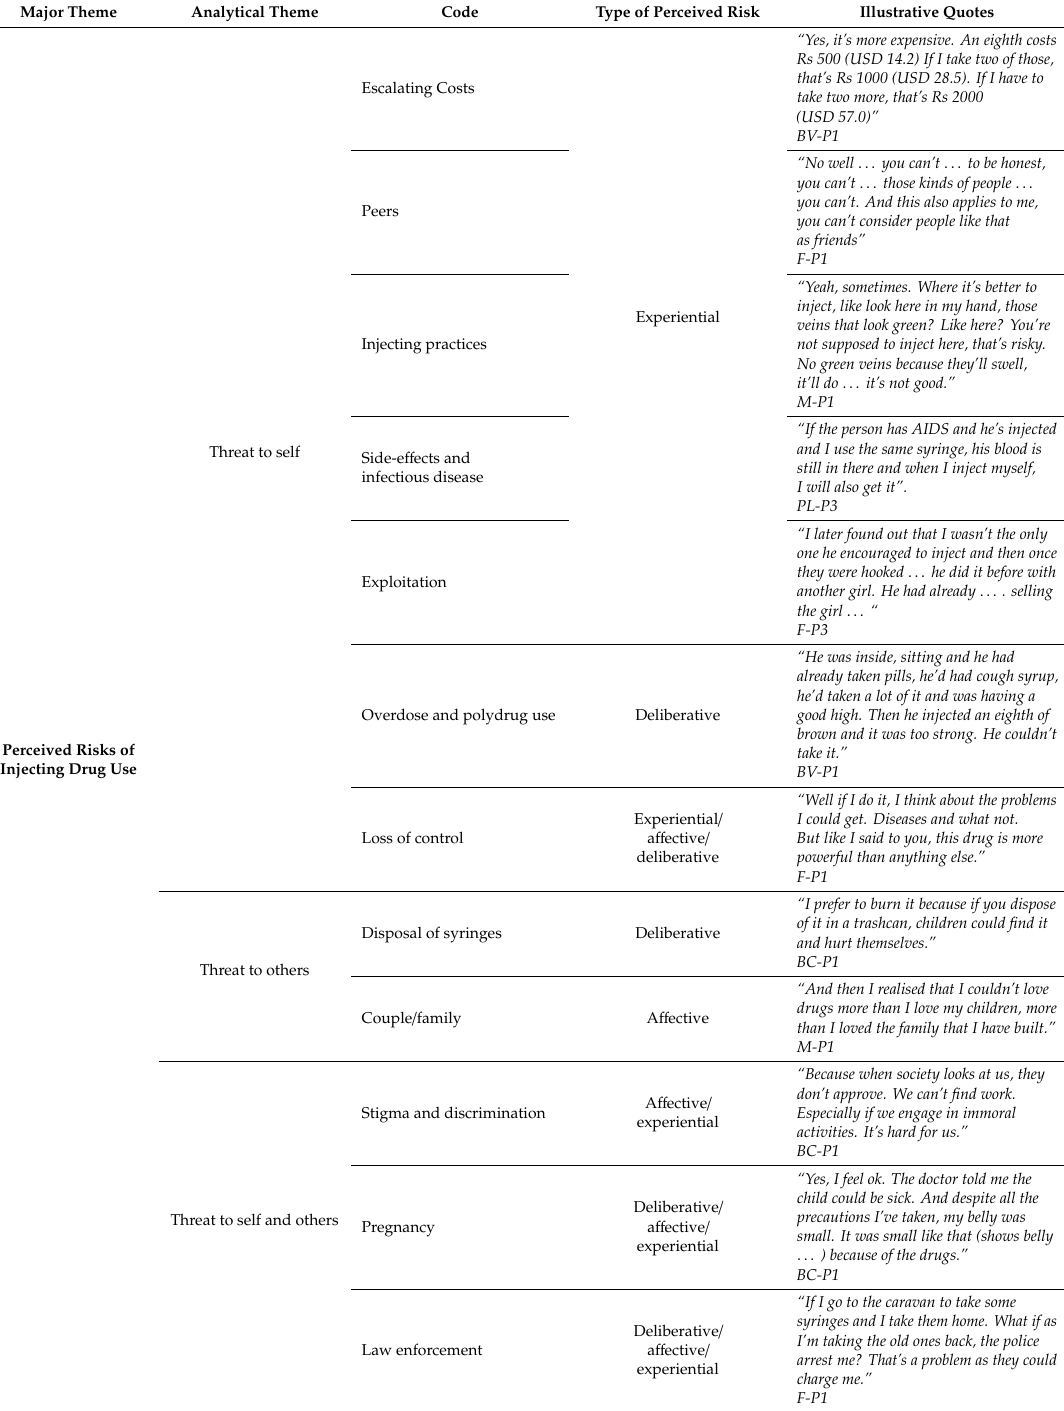
Table 5. Perceived risks of illicit drug use among heroin